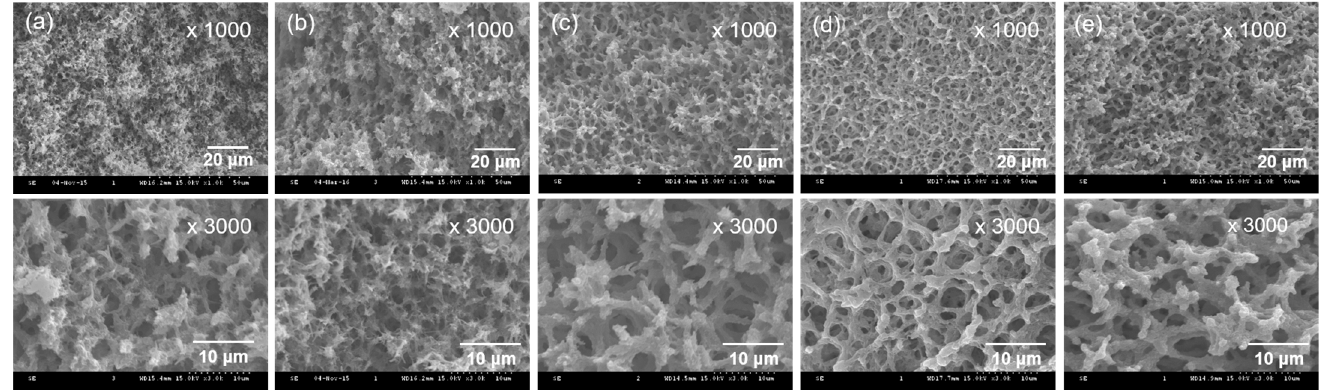
Figure 2. SEM images of ( a ) CA, ( b ) CE, ( c ) CEEP, ( d ) CEAM, and ( e ) CEPP (CEPP20) monoliths.